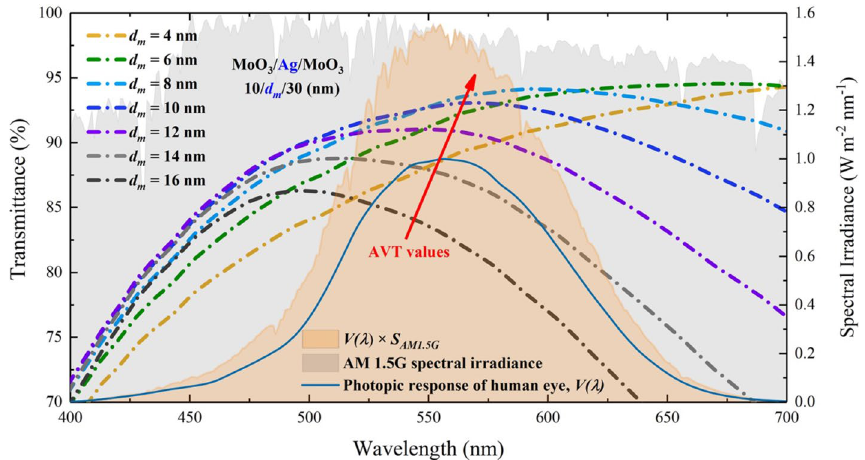
Figure 3. Analysis of the transmittance spectrum and AVT values of the MoO 3 /Ag/MoO 3 ( 10 nm / d m / 30 nm ) S AM 1.5 G ( (cid:31) ) changes. The orange shaded area is related transparent top contact under V ( (cid:31) ) , AM 1.5G and V ( (cid:31) ) × S AM 1.5 G ( (cid:31) ) and the area is the value of the integral in the denominator of Eq. to the change of V ( (cid:31) ) ×